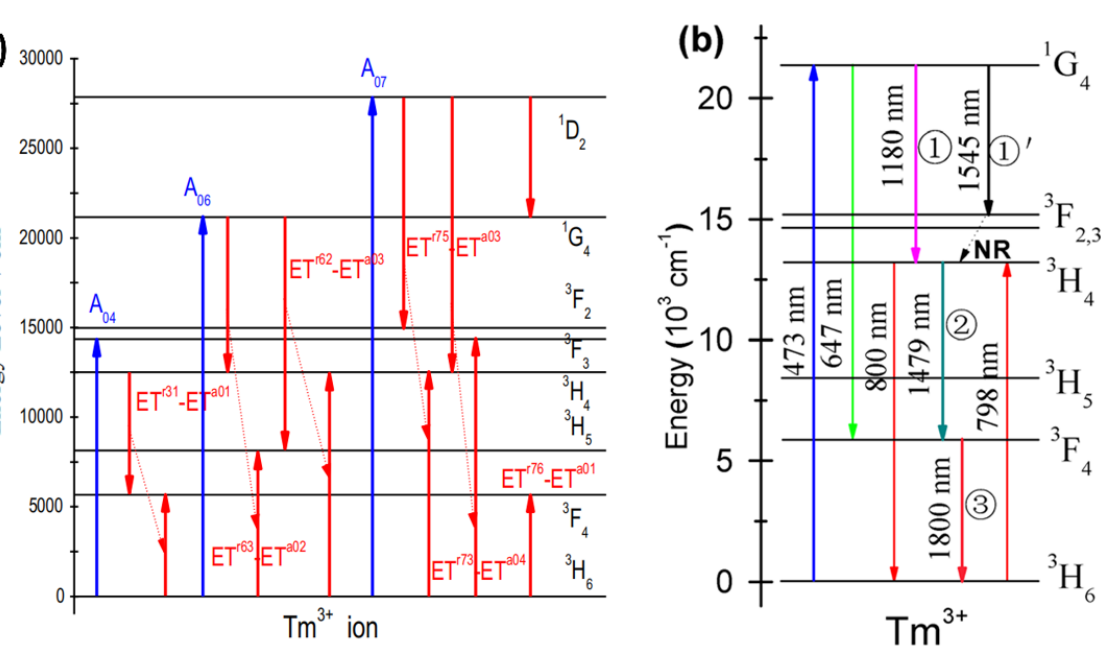
Figure 7. ( a ) Schematic diagram of the energy-level structure and quantum-cutting process of Tm: YNbO 4 powder phosphor. ( b ) Energy-level diagram of Tm 3+ schematically illustrating the ET mechanisms, mainly involving the sequential three-step three-photon